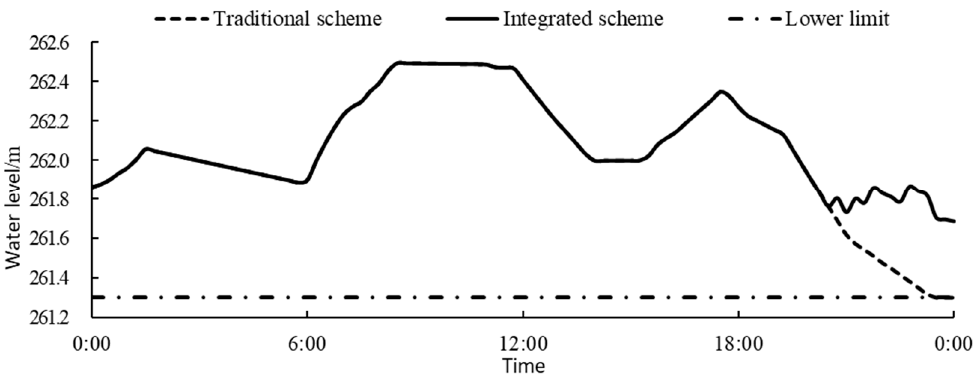
Figure 6. Water level variation of each scheme in the 3rd operating condition.